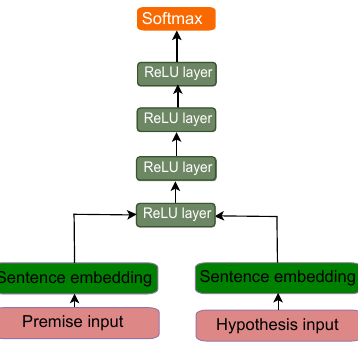
Figure 10. RNN architecture for sentence embedding [63].